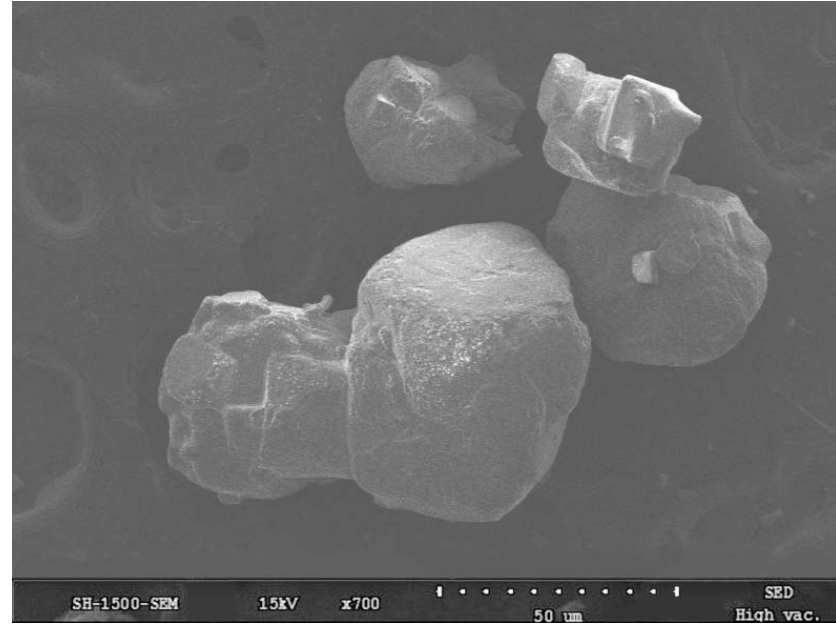
Figure 1. The SEM image of snow melting chloride